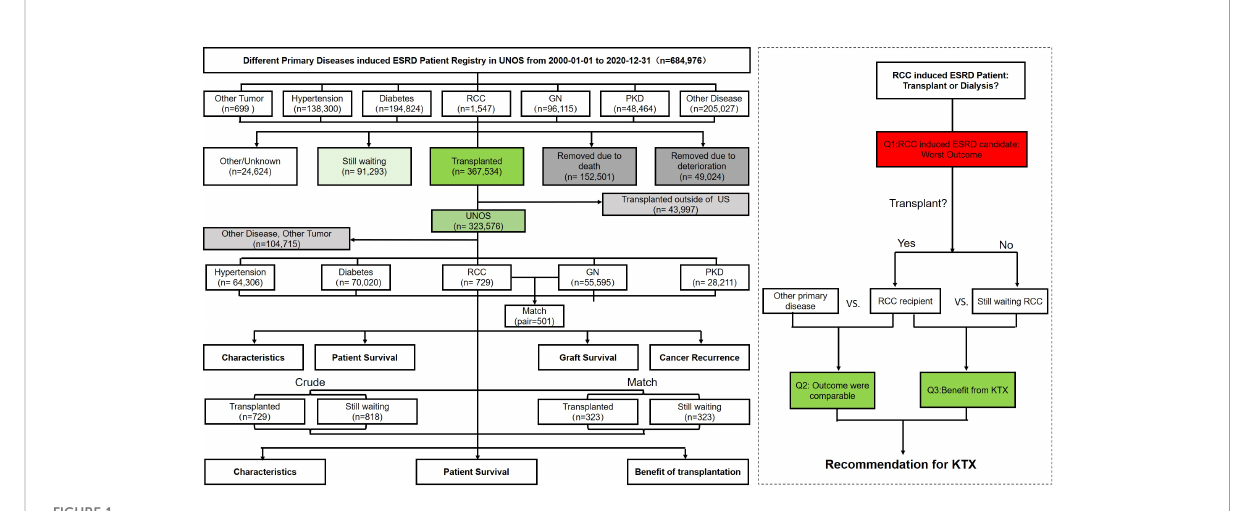
FIGURE 1 Flowchart of the study cohort enrollment